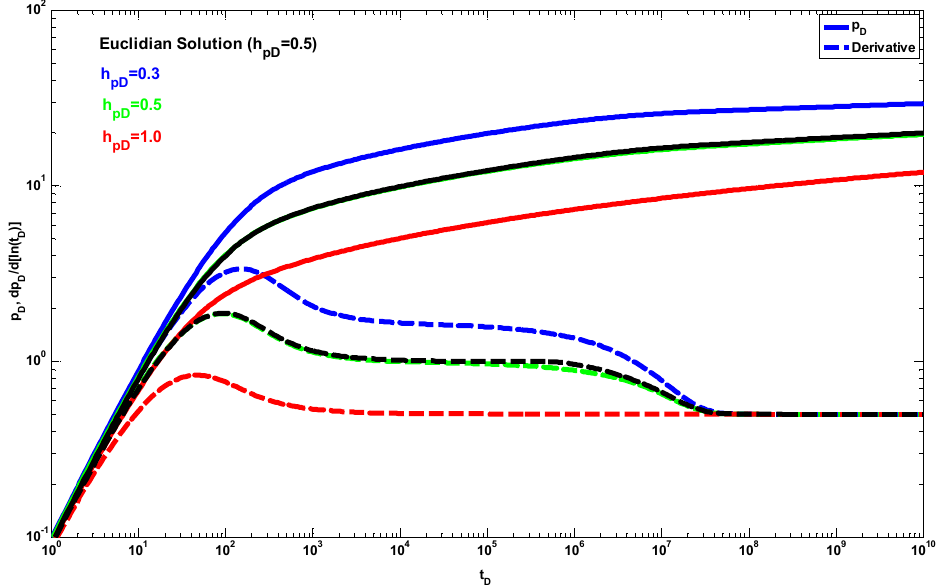
Figure 3. Euclidean case: z wD = 0, h D = 10,000, S = 0, C D = 10, ε = 1, d fr = 2, θ r = 0, d fz = 1, θ z = 0 .